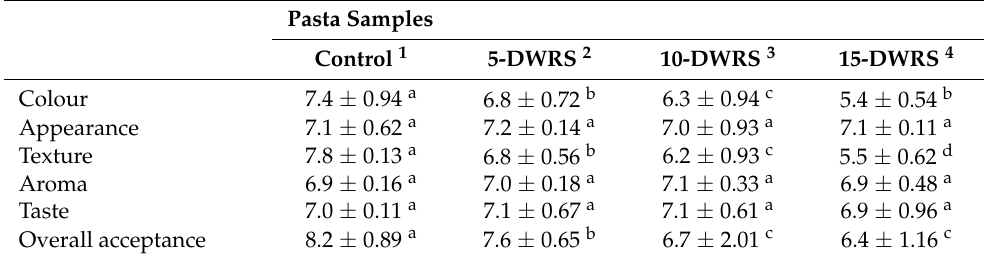
Table 4. Sensory scores of semolina spaghetti containing resistant starch (RS) from debranched waxy rice starch